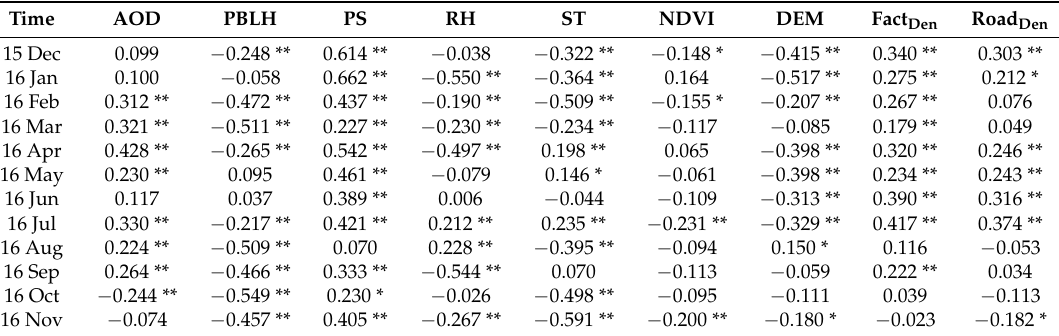
Table 3. Monthly Pearson Correlation Coefficients between PM 2.5 and other